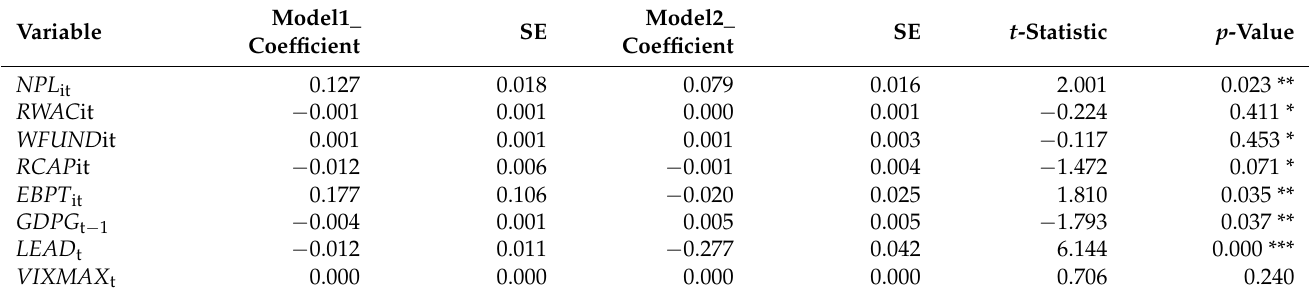
Table A8. Comparison of pre-crisis (adjusted) (2) and post-crisis (adjusted) (6).